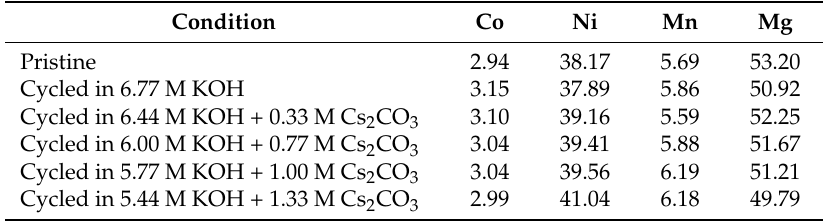
Table 6. ICP results in at % of the fresh and cycled AR3 in five different electrolytes.